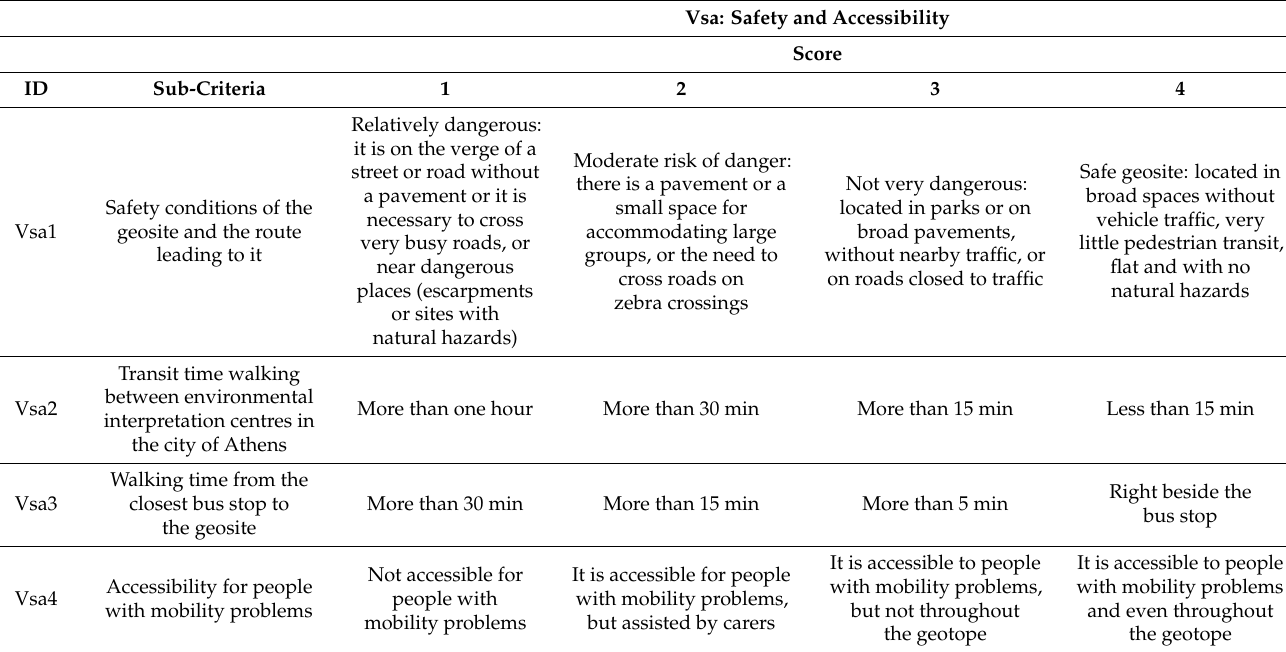
Table 4. Safety and accessibility and sub-criteria [64,65] (modified by us).